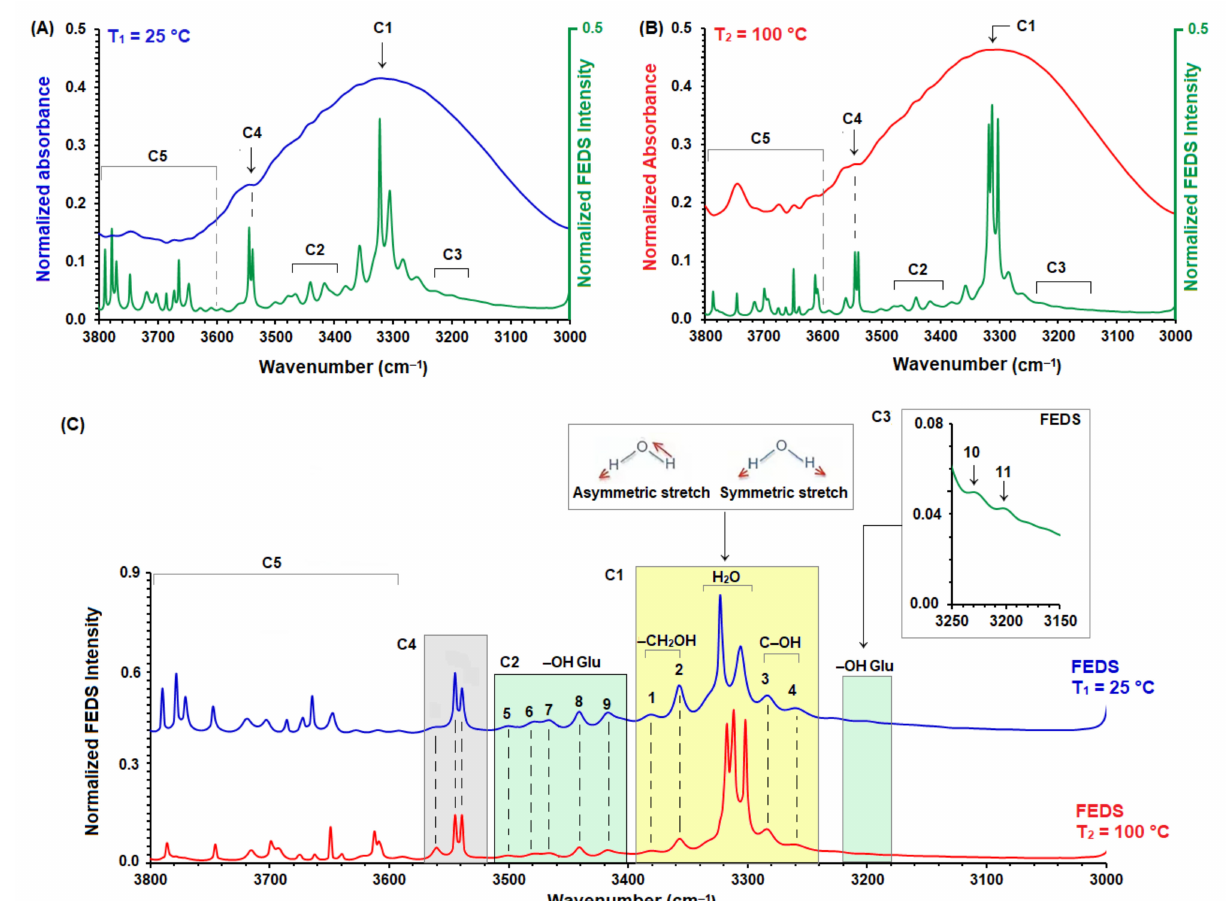
Figure 2. Normalized infrared and FEDS spectra of Cassava starch for T 1 ( A ) and T 2 ( B ) among 3800 and 3000 cm − 1 , and ( C ) comparison of FEDS spectra for T 1 and T 2 among 3800 and 3000 cm − 1